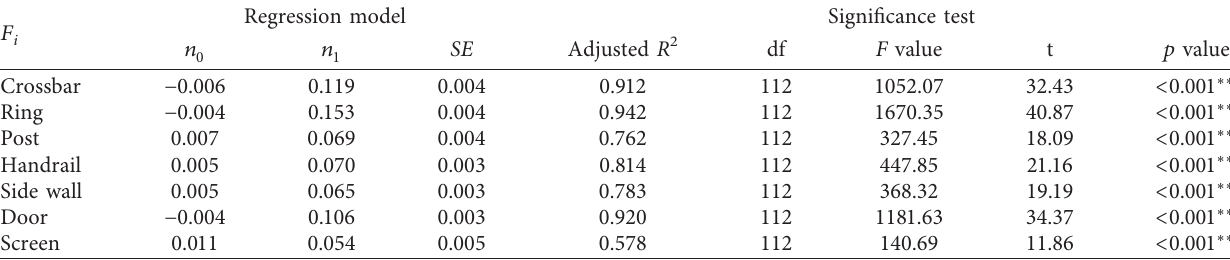
Table 6: Prediction model of occupancy rate of facility.